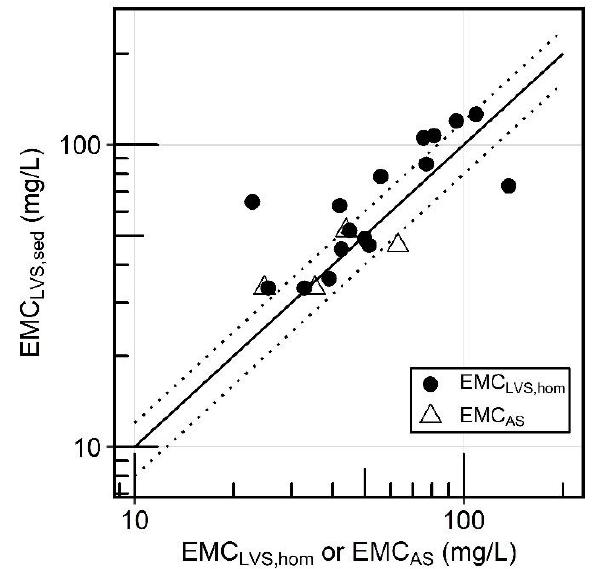
Figure 7. Scatterplot of TSS event mean concentrations derived from homogenized (EMC LVS,hom ) and sedimented (EMC LVS,sed ) large-volume samplers samples. Triangles show the EMC derived from autosamplers (EMC AS ) pollutographs of the same events compared with sedimented samples. Dotted lines show 20% deviation.